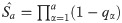
Illustrating the estimated pooled baseline discrete hazard and survival functions from the 2011 Burundi DHS dataset, fit using the seven age bins a ∈ (1 = NN,2 = PNN1,3 = PNN2,4 = 1yr,5 = 2yr,6 = 3yr,7 = 4yr). Note that we are estimating discrete hazards, and thus, hazards (shown in panel B) are interpreted as a conditional probability rather than a conditional rate. The survival function (shown in panel A), showing estimated survival at the end of each age bin, is calculated directly from estimated hazards as S^a=∏α=1a(1−qα). DHS, Demographic and Health Surveys; NN, neonatal; PNN1, post-neonatal 1; PNN2, post-neonatal 2.